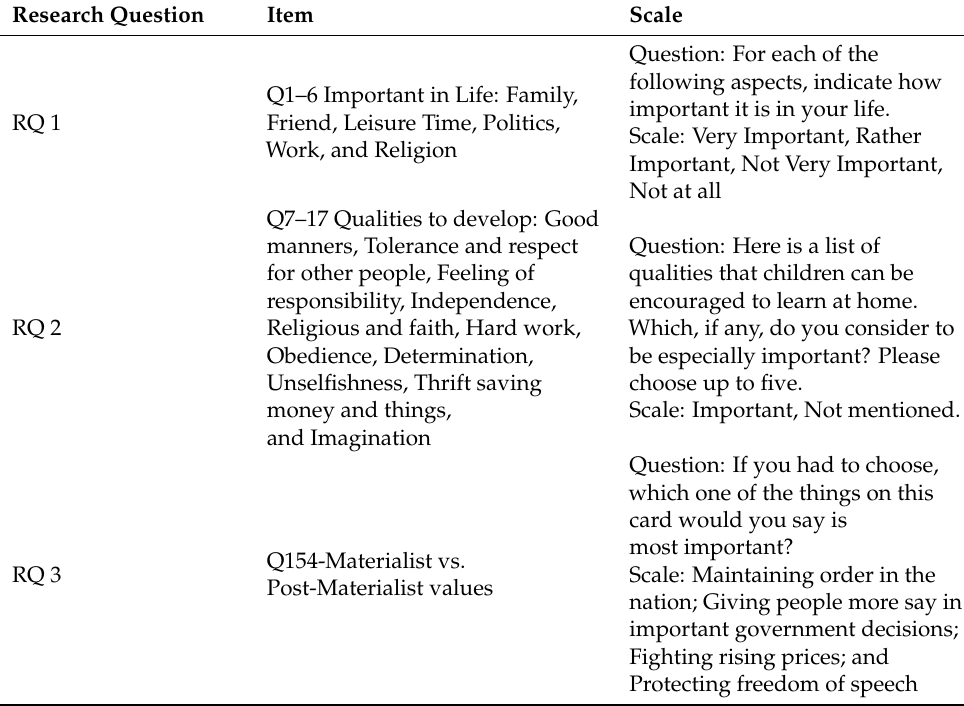
Table 3. Selected items and scales from World Values Survey in matching the research questions. Source: Adopted and adapted from